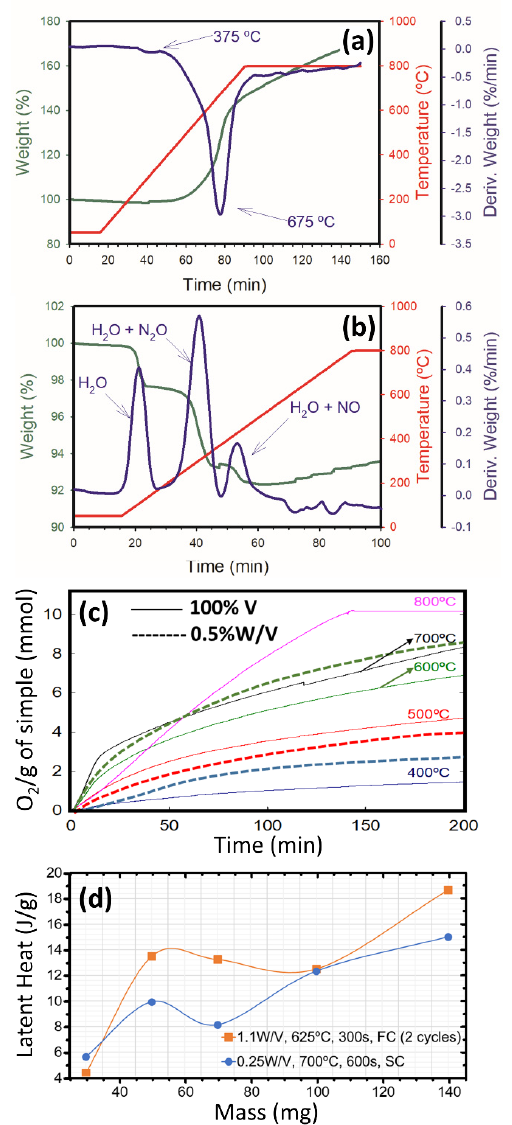
Figure 5. TGAs of V NPs ( a ) and of (NH 4 ) 6 H 2 W 12 O 40 ·xH 2 ( b ) in oxidative atmosphere. ( c ) Kinetic curves for isothermal processes of oxidation. ( d ) Values of enthalpy of MIT transformation at heating indicative of the VO 2 yields, for different masses of V plus W subjected to optimal treatments of oxidation for pure V: 1-cycle with slow cooling (SC), and 2-cycles with fast cooling (FC). Even though the achieved effect by doping is very modest in the one cycle optimum, there are significant results for the two cycles treatments combined with W pre- impregnations. Figure 6 shows the effect of continuously increasing the content of tungsten on the position, shape and area of the DSC endothermic peak related to the heating of the product containing effectively doped portions of vanadium dioxide. Note that every exothermic peak at cooling was always relatively symmetric to its couple, and positioned at a randomly lesser temperature between 5 and 8 °C lower, so this value of the hysteresis gap does not follow any tendency. Figure 6a presents one example of the DSC experiment for most of the tested compositions, showing a clear monotonic